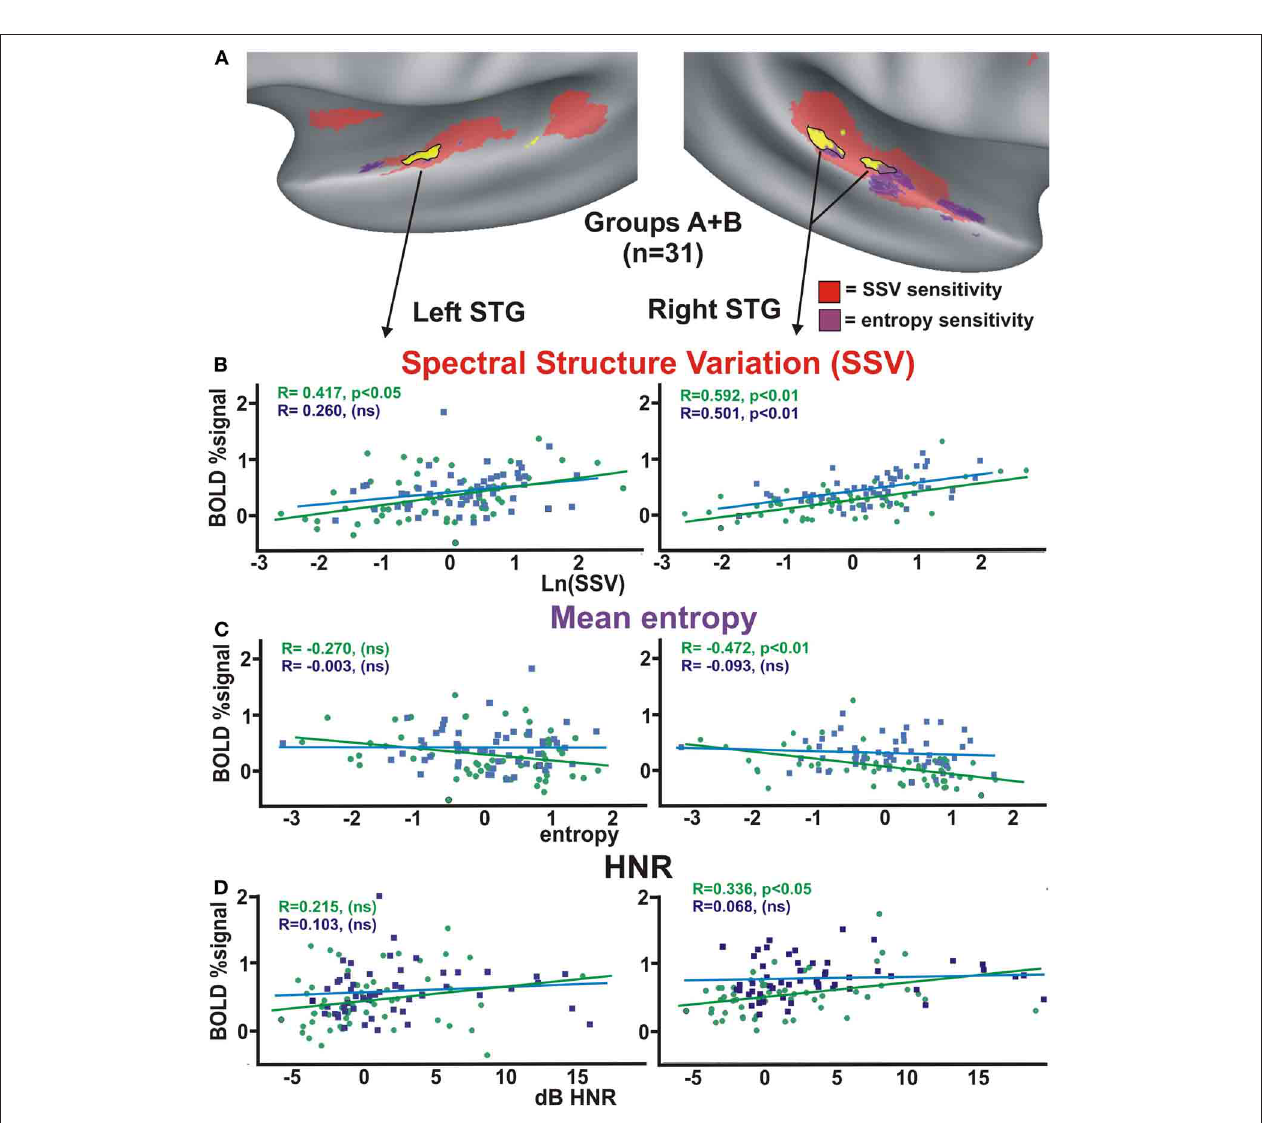
(ln(SSV), z -normalized) of the sounds as a function of Likert ratings did revealed significant correlations for both the mechanical (blue) and environmental (green) sounds. (C) Chart derived from panel B showing only the set of 28 extreme rated sounds from Figure 1B . See text for other details.